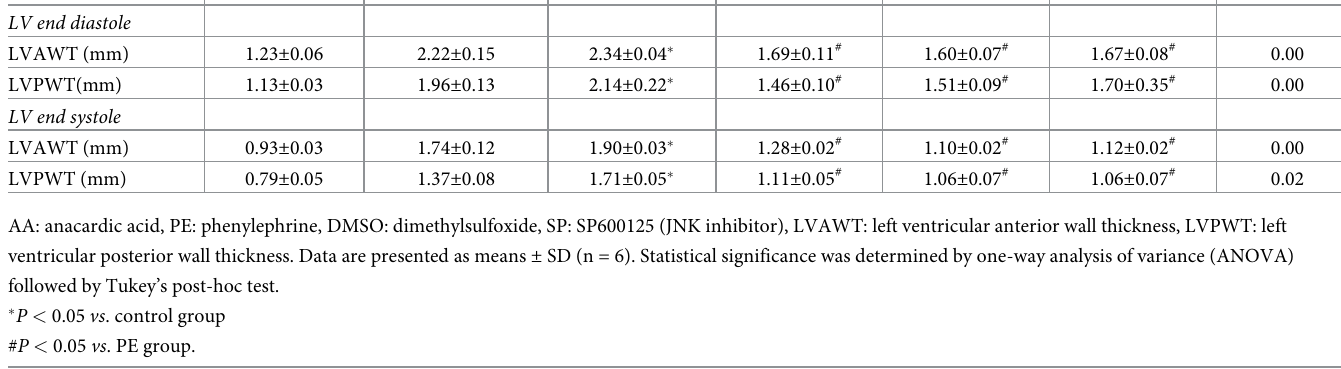
Table 1. Left ventricular wall thickness measurement with echocardiography (n = 6). Control